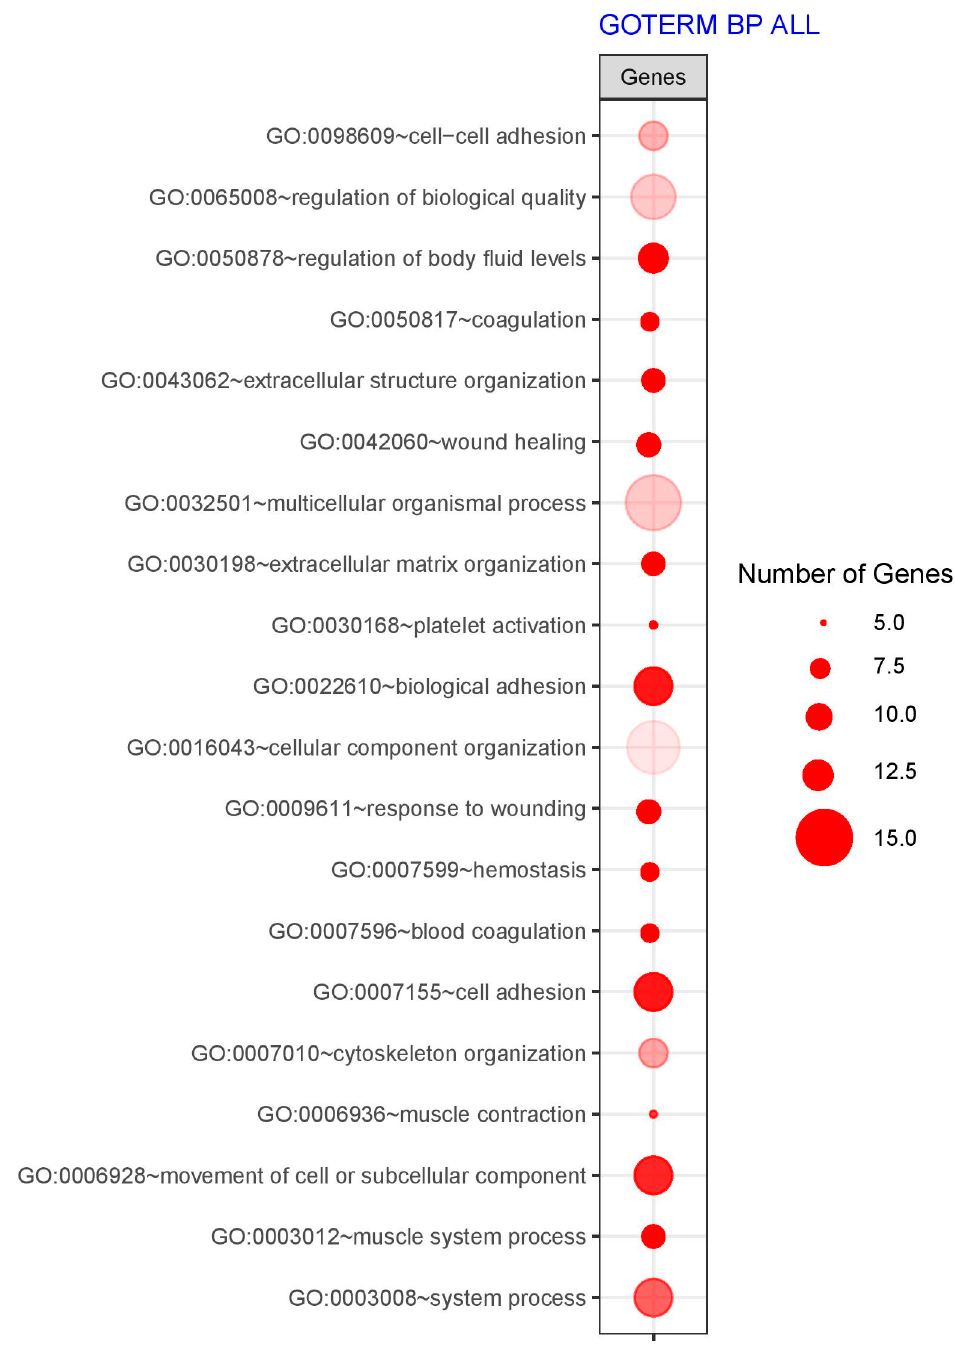
Figure 4. The plot showing the list of enriched gene ontology biological processes (GO BP) terms. The size of the circle corresponds to the number of genes. The color intensity indicates the fold enrichment of the terms.